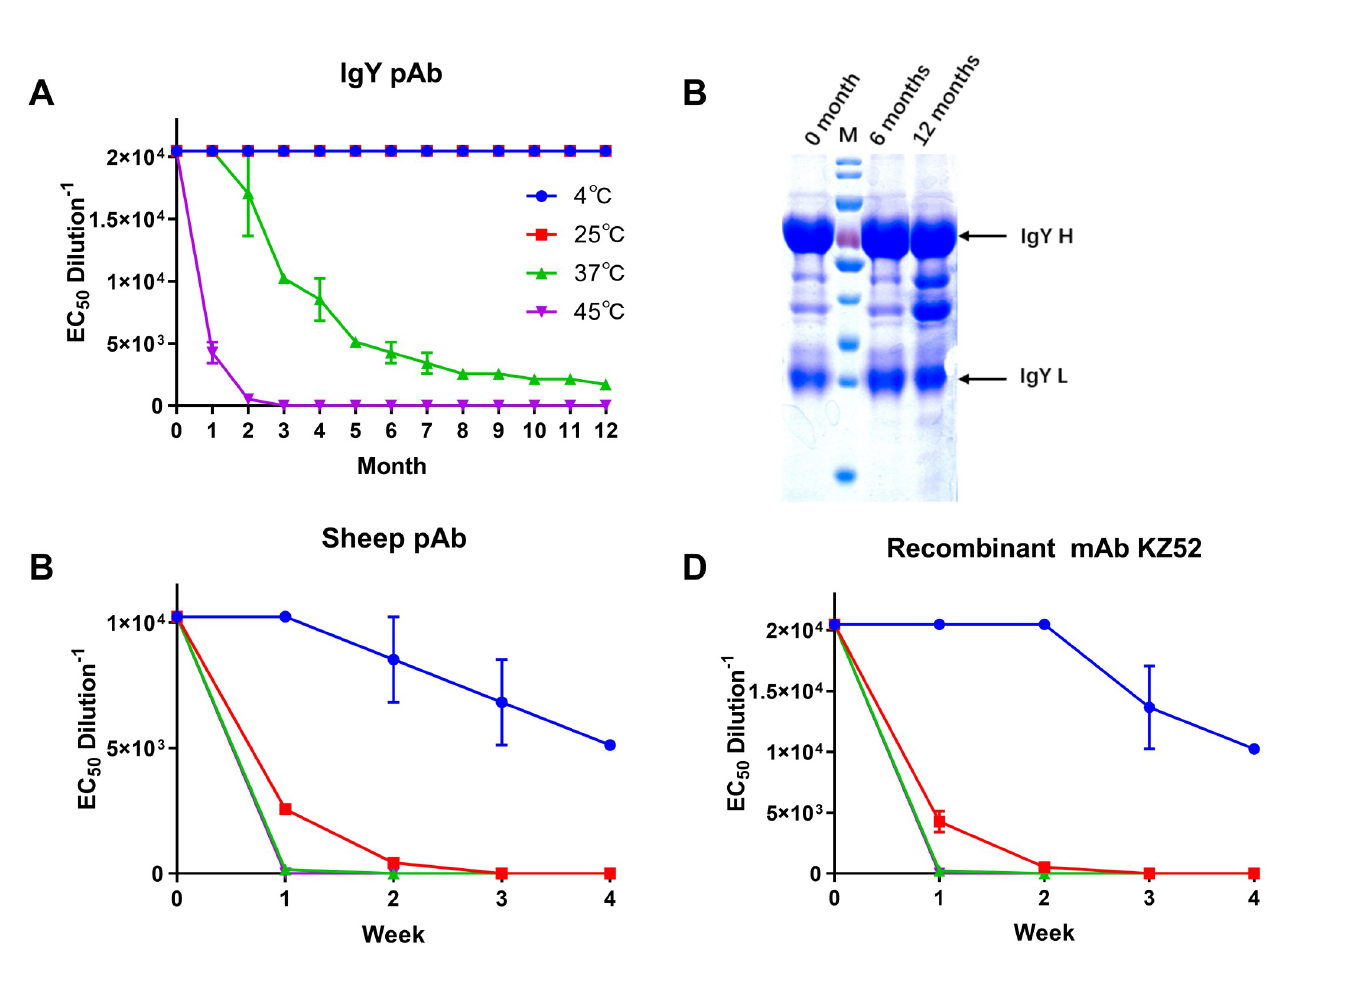
Fig 6. Thermal stability analysis of IgY pAb, sheep pAb and recombinant mAb against EBOV. Three different types of antibody solutions were placed under different temperature conditions (4˚C, 25˚C, 37˚C, and 45˚C) for 1 year or 4 weeks and NAb titers were detected per month (A) or week (C, D). The IgY stored at 25˚C for 0, 6 and 12 months were analysed by SDS-PAGE (B). Data are shown as means ±